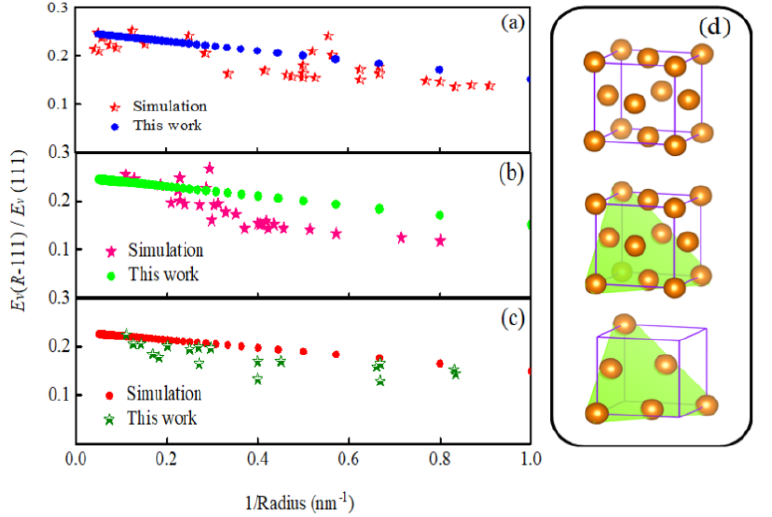
Figure 3. Size effect of the vacancy formation energies on ( a ) Au, ( b ) Ag, and ( c ) Cu nanoparticle (111) crystal surfaces, and ( d ) changes in the coordination numbers of (111) crystal surfaces of face-centered cubic crystals. (The detailed calculation parameters: CN is the coordination number12, η is the packing coefficient 0.74, r 0 is the atomic radius 0.1442, and R is the nanoparticle radius, ρ b / ρ n is density ratio 0.9, k is the ratio factor of the surface to the whole 0.25, the relevant data can be found in the Supplementary Materials Tables S7–S9.)